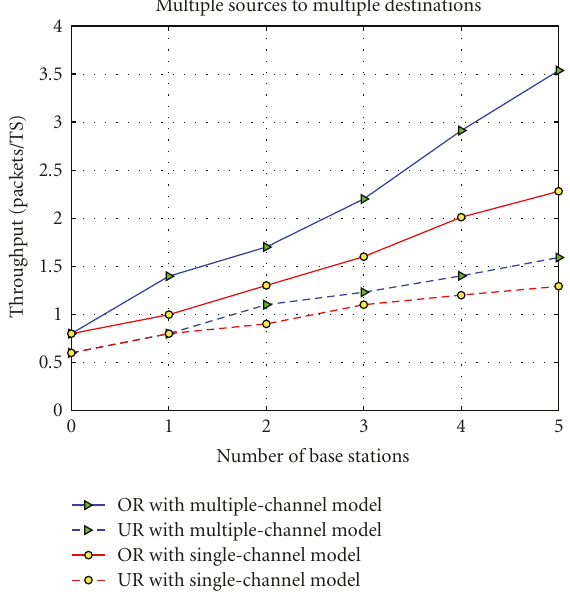
Figure 7: Bound of throughput from Multiple Sources to Multiple